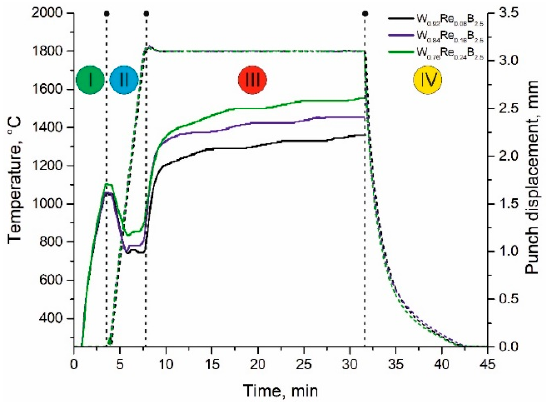
Figure 1. Sintering curves of W 1 − x Cr x B 2.5 (0 < x ≤ 0.24) samples spark plasma sintered for 24 min. Dotted lines are temporal distribution of sintering temperature.